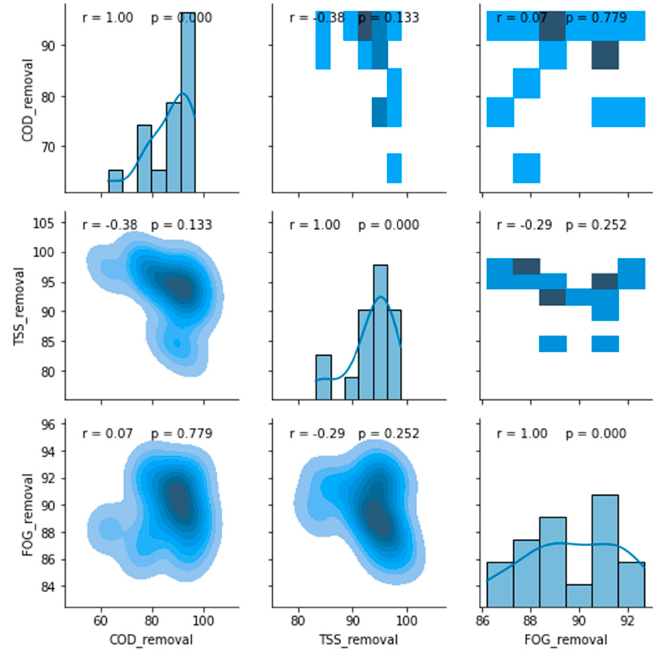
Figure 18. Correlation matrix between removal efficiencies of the DEGBR.